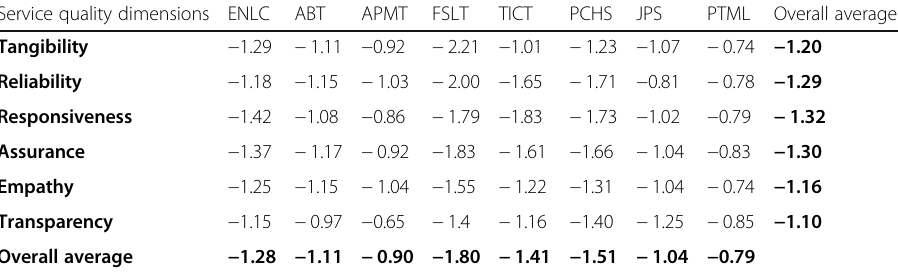
Table 10 Average gap scores across service quality dimensions and terminals Service quality dimensions ENLC ABT APMT FSLT TICT PCHS JPS PTML Overall